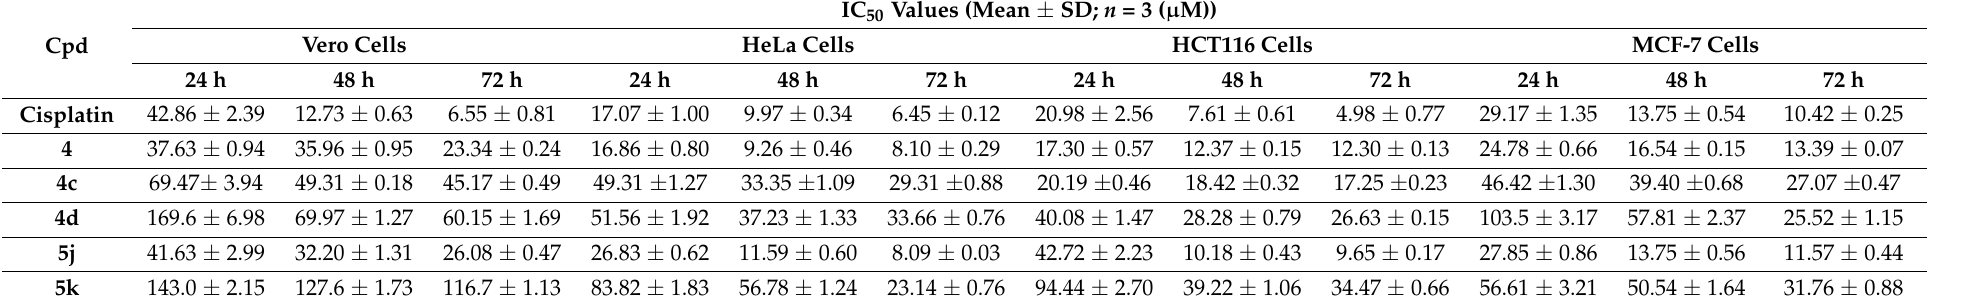
Table 3. Antiproliferative activities of potent HDAC inhibitors against non-cancer and cancer cell lines.